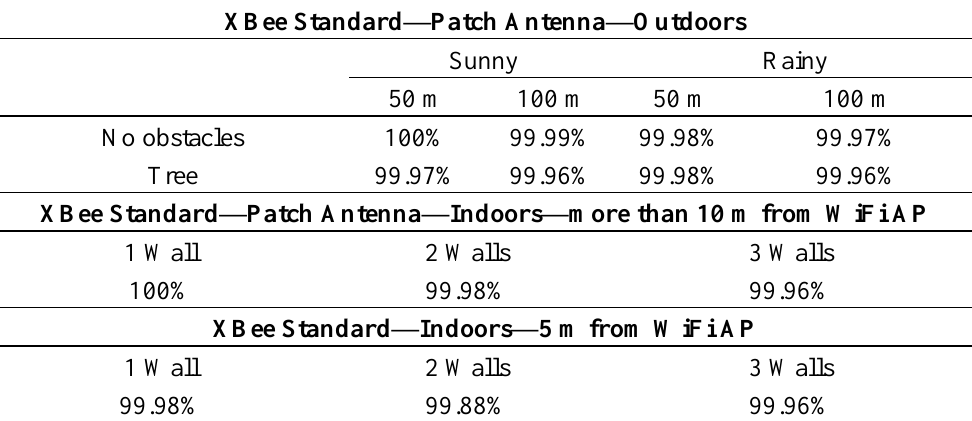
Table 4. ZigBee reliability